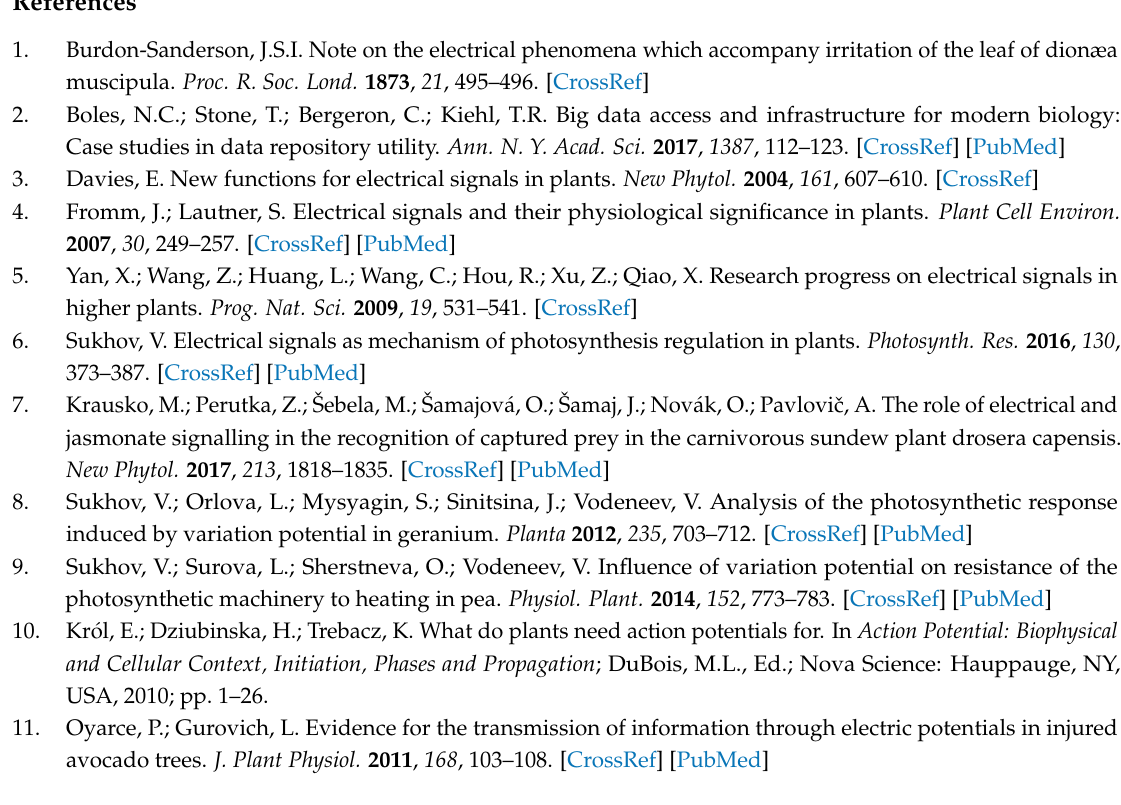
s1, Figure S1: MySQL EER Diagram, Methods S1: The electrical signals extraction of plant fluorescence image, Methods S2: The visualization process of plant electrical